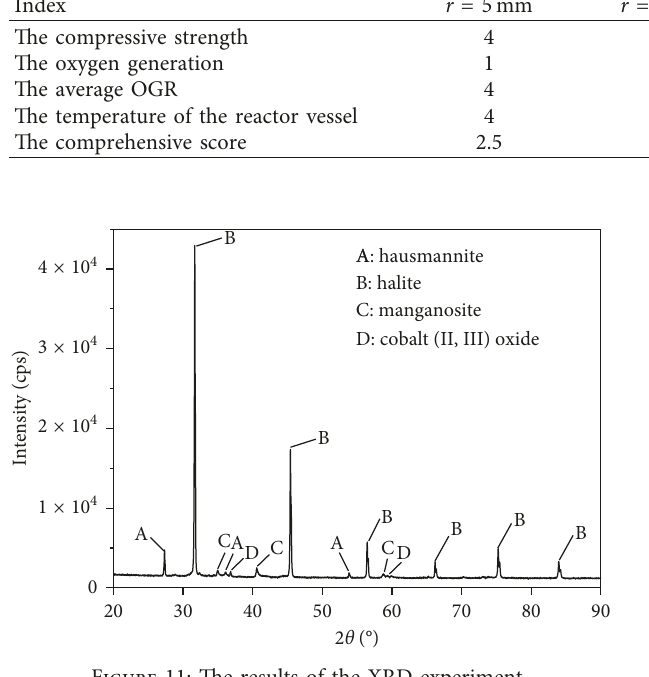
Figure 11: The results of the XRD